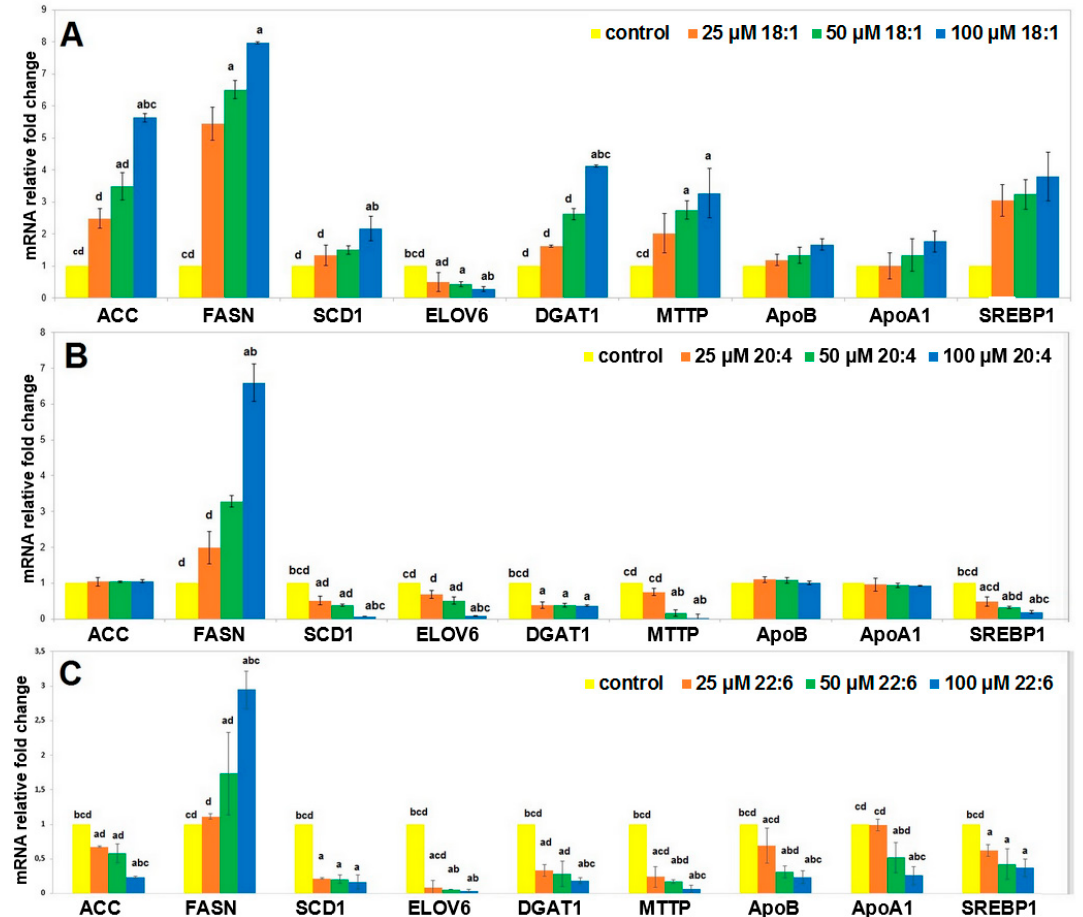
Figure 2. mRNA levels for selected genes expressed in HepG2 cells supplemented with various concentrations of oleic acid (OA; A ), arachidonic acid (AA; B ) and docosahexaenoic acid (DHA; C ). Data are shown as mean ± SEM. Groups significantly different by one-way ANOVA ( p < 0.05): a— p < 0.05 compared to the control; b— p < 0.05 compared to the cells treated by 25 µM FA; c— p <